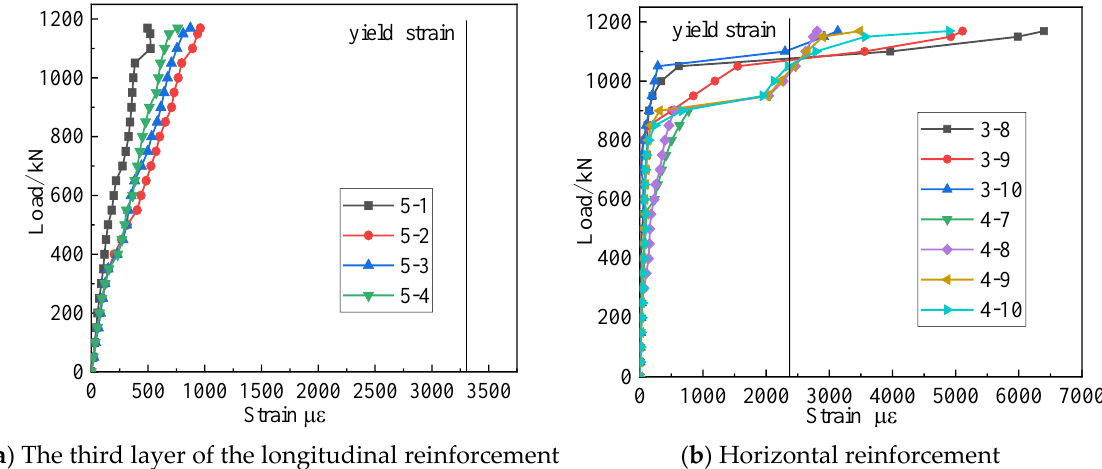
Figure 11. Reinforcement strain of test specimen LDB1.